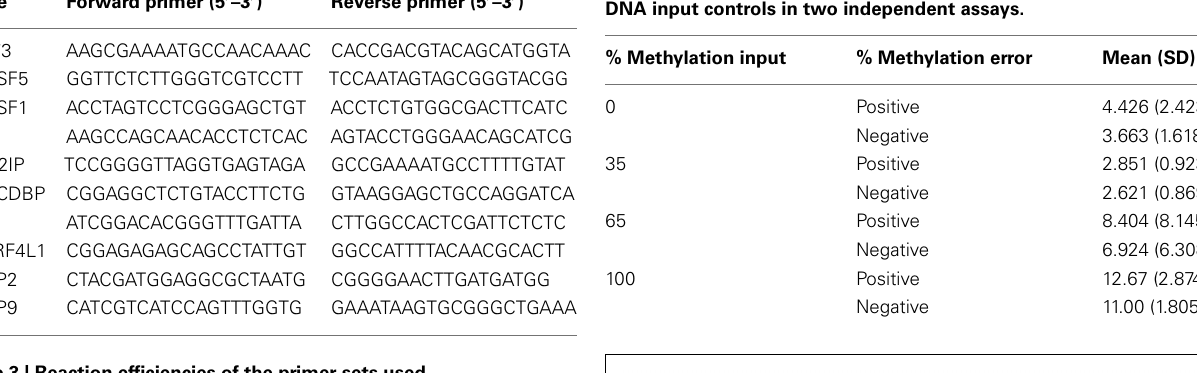
Table 3 | Reaction efficiencies of the primer sets used.